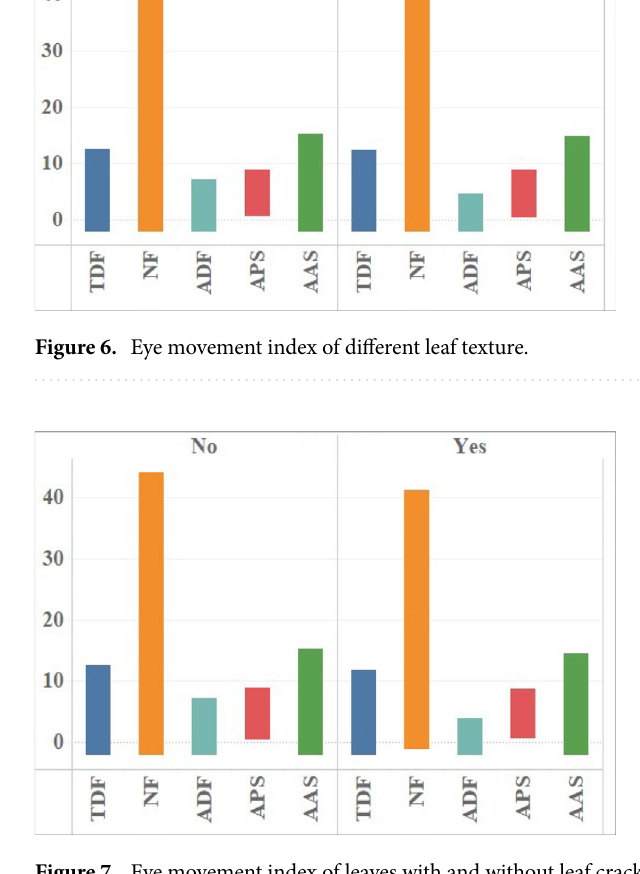
Figure 7. Eye movement index of leaves with and without leaf crack.